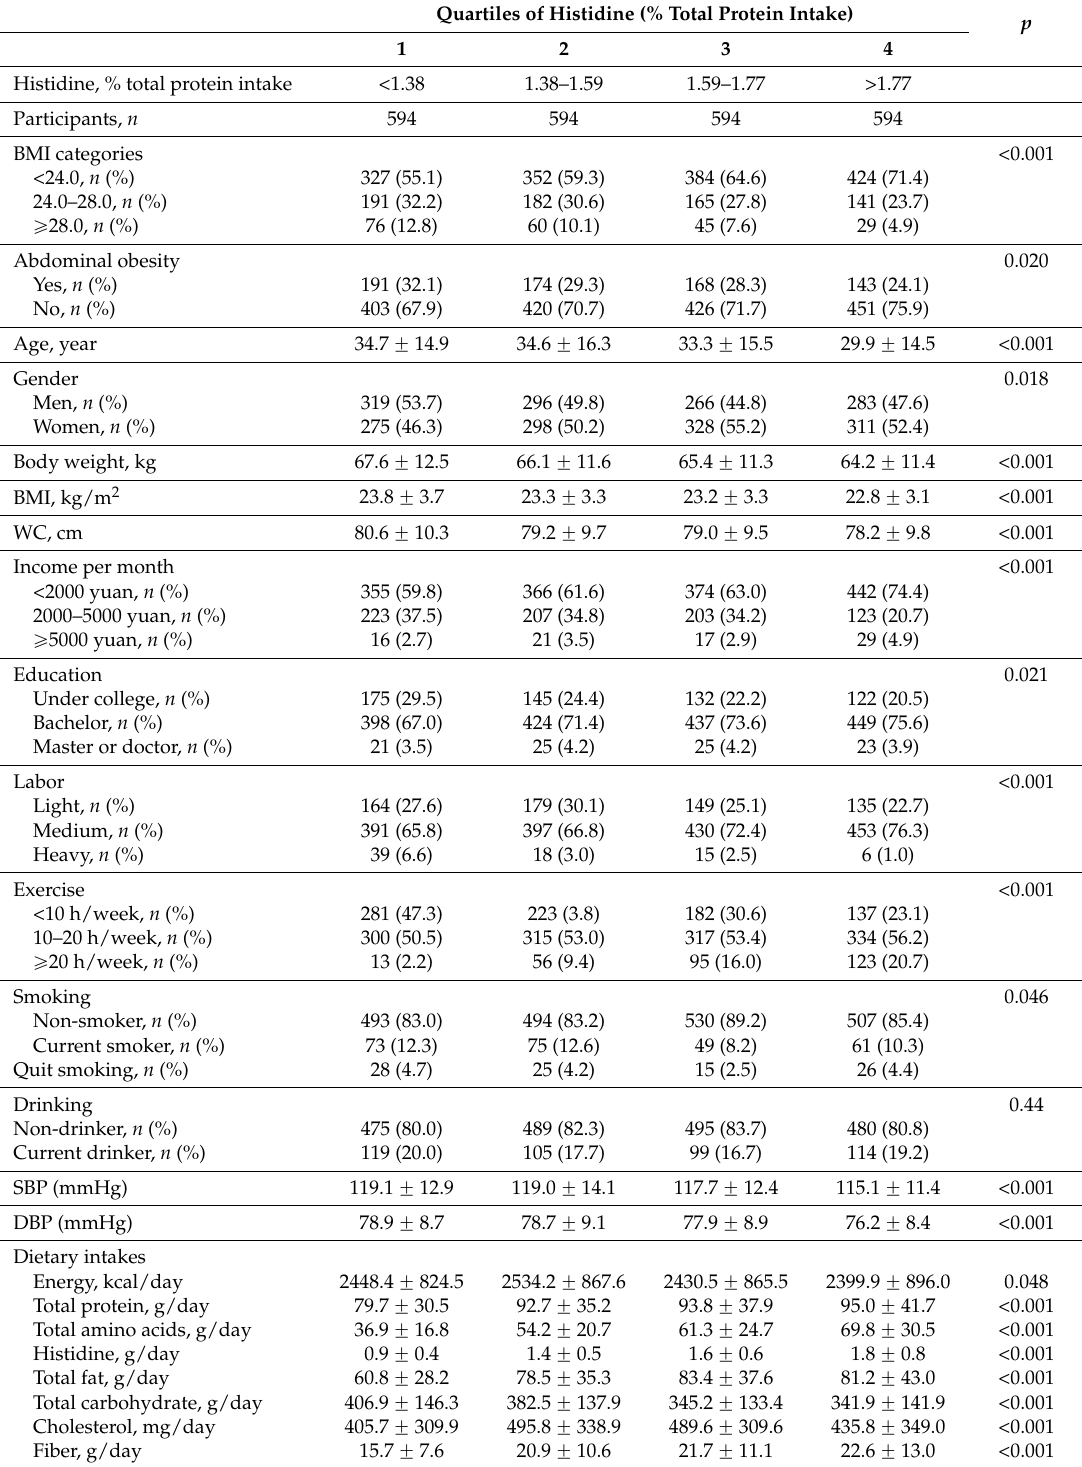
Table 1. Characteristics and dietary intake of participants by quartile of histidine